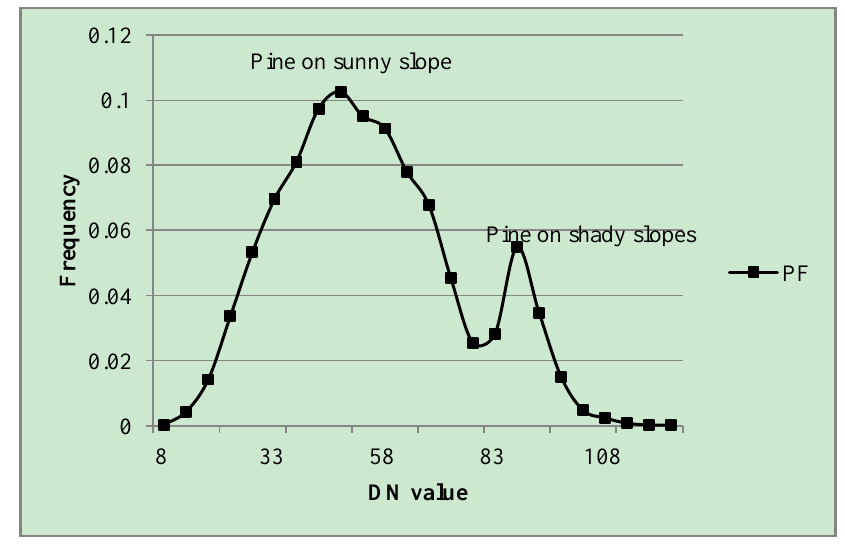
Table 14. Pearson correlations of CCA axes with topographic and human disturbance attributes.